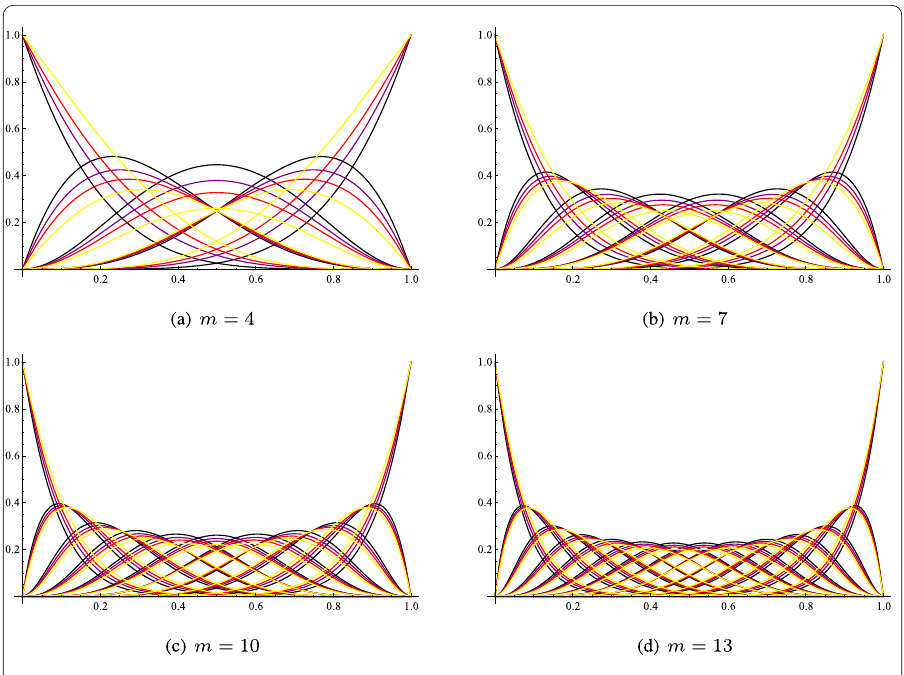
Figure 1 GBTB basis functions of different order with different shape parameters